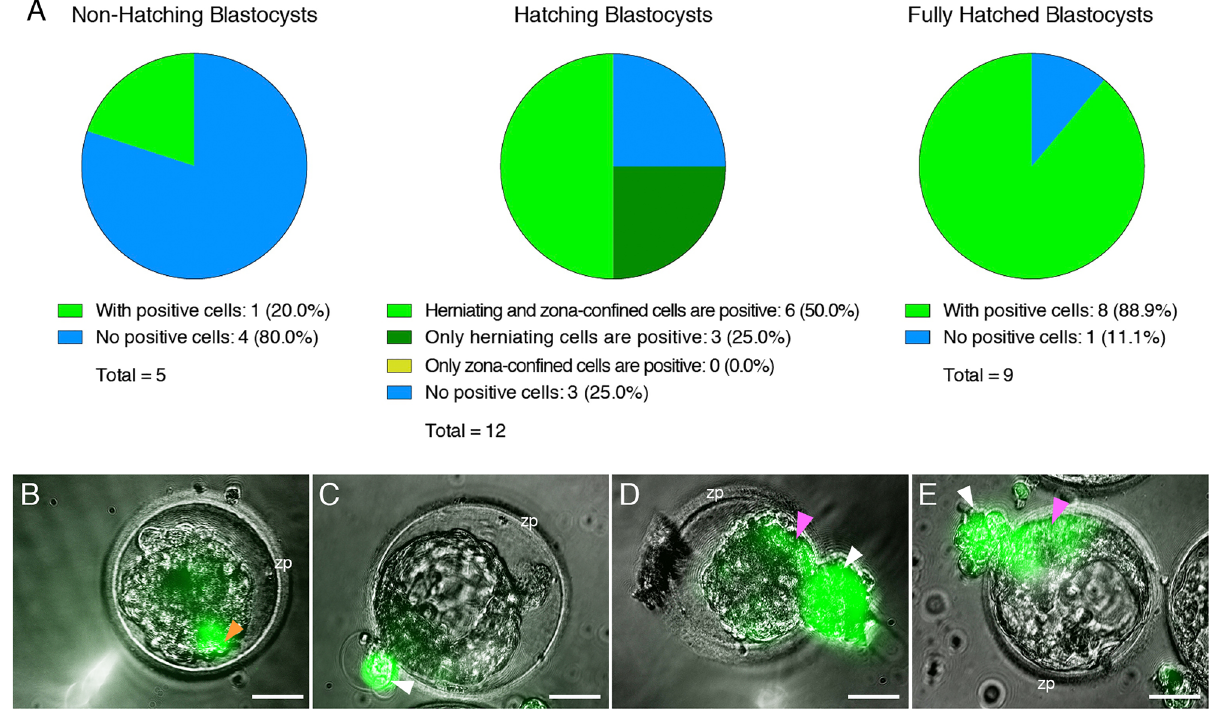
Figure 5. The Zona Pellucida Might Confer Protection Against SARS-CoV-2 Infection. ( A ) Pie charts indicating the proportion of blastocysts displaying evidence of infection at three separate stages of development (before, during, and after hatching), when exposed to live SARS-CoV-2 expressing a fluorescent reporter (in the presence or absence of control IgG blocking antibody). Non-hatching blastocysts have an intact zona pellucida, hatching blastocysts have some cells herniating out of the zona pellucida opening as well as some cells confined in the zona pellucida compartment, and fully hatched blastocysts have emerged completely out of the zona pellucida. ( B ) Only example of a non-hatching blastocyst with zona pellucida-encapsulated positive cells (orange arrowhead). ( C ) Example of a hatching blastocyst with positive cells exclusively in the herniating compartment. ( D , E ) Examples of hatching blastocysts, with positive cells in the herniating compartment (white arrowheads) as well as in cells proximal to the zona pellucida opening (pink arrowheads). zp = zona pellucida. Scale bars represent 50